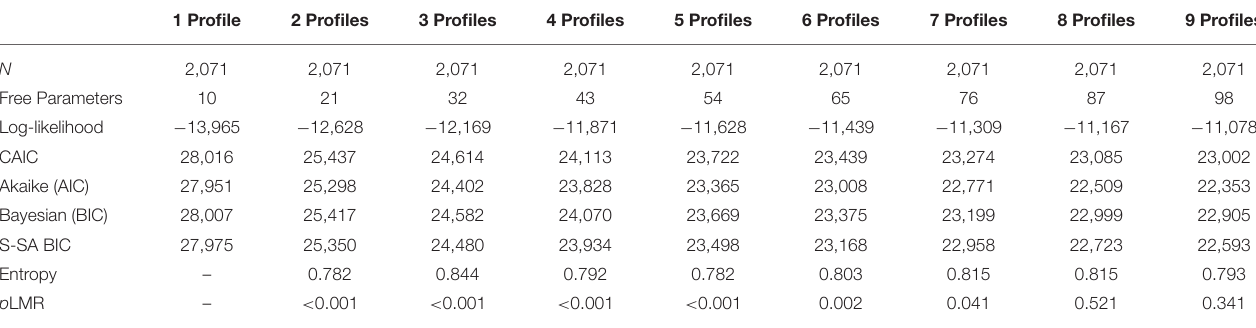
TABLE 2 | Single-level LPA fit